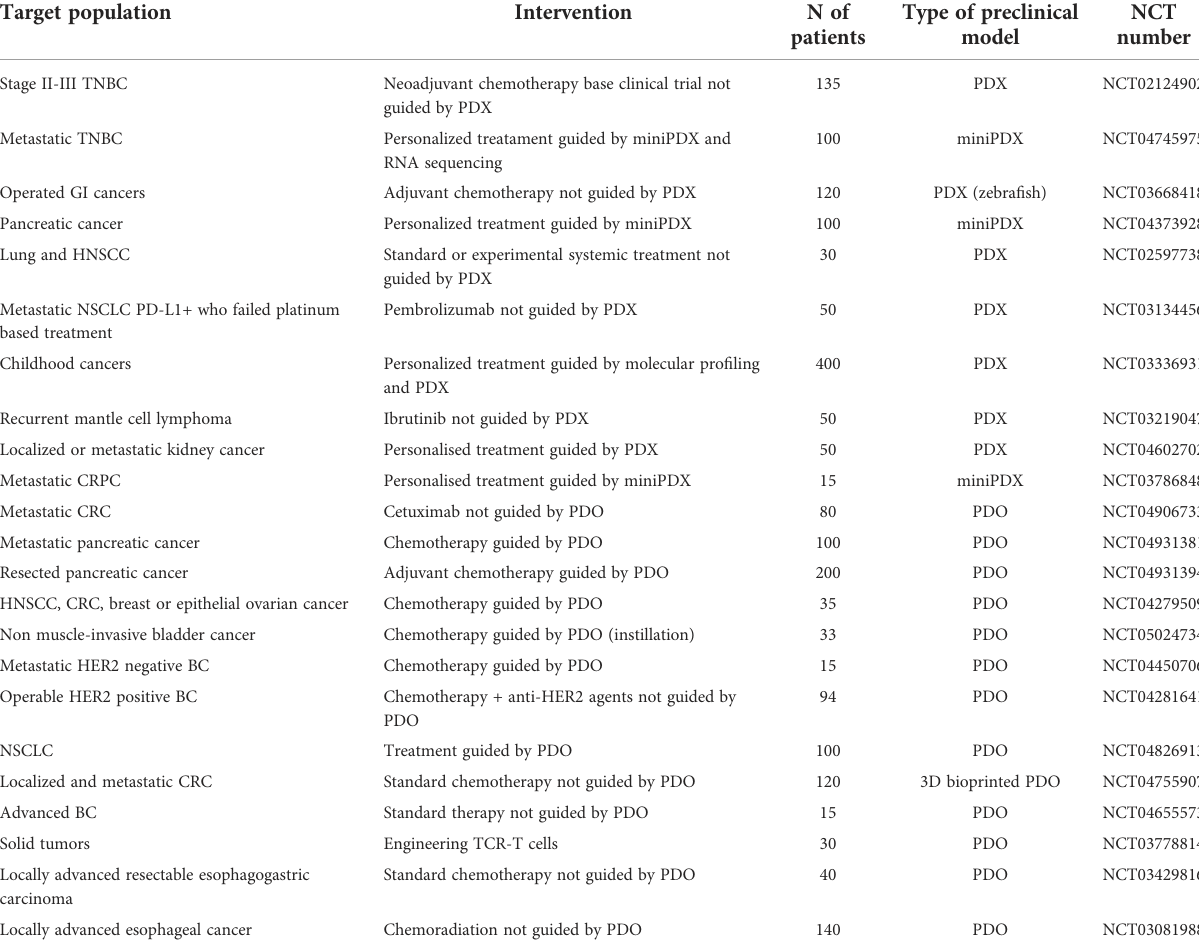
TABLE 1 Ongoing co-clinical trials using patient-derived models for drug